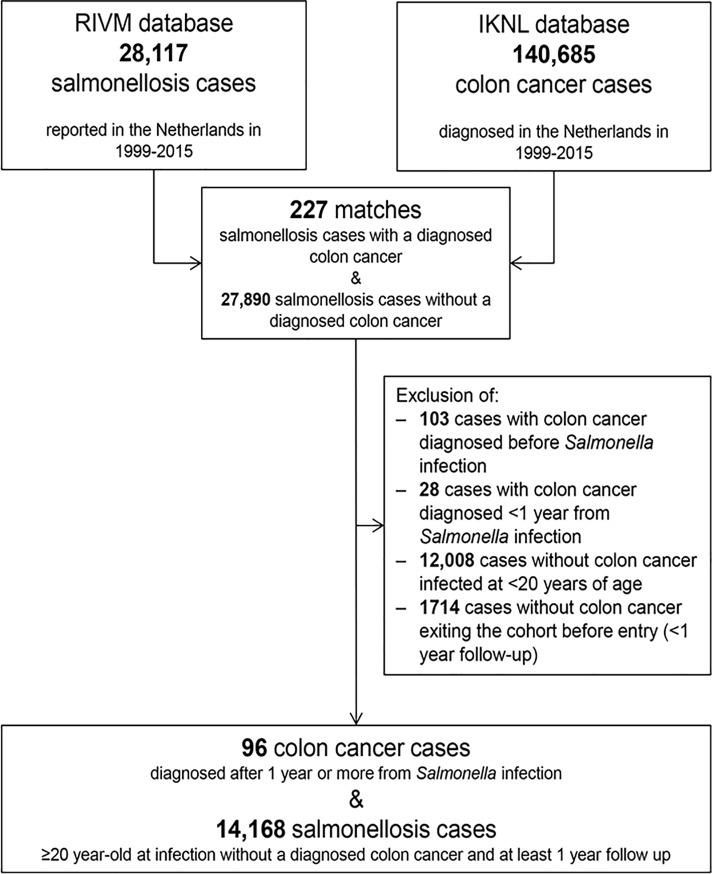
Schematic representation of the data management process.Number of patients in the two linked databases, as well as the number of patients excluded from further analyses according to each inclusion criterion.